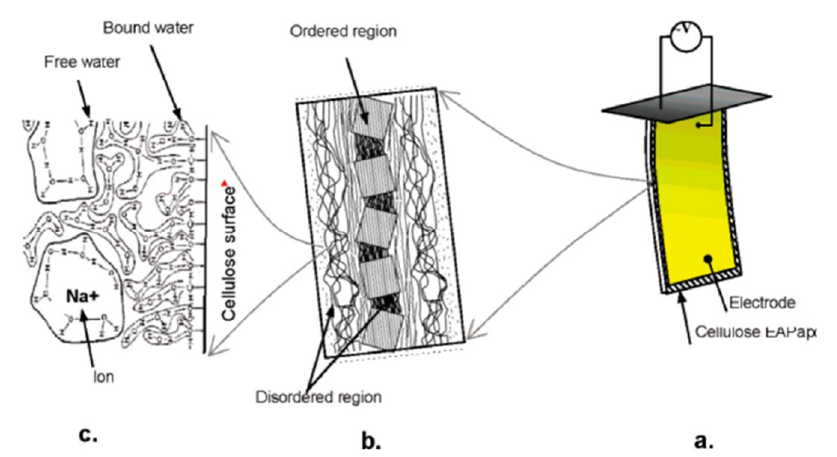
Figure 1. Concept of electro-active paper (EAPap) actuator: ( a ) EAPap is made from cellulose paper on which gold electrodes are deposited on both sides; ( b ) cellulose microfibril has ordered crystalline regions and disordered regions; ( c ) water molecules are bonded with hydroxyls on the cellulose surface (bound water) or clustered in free (free water) [21].